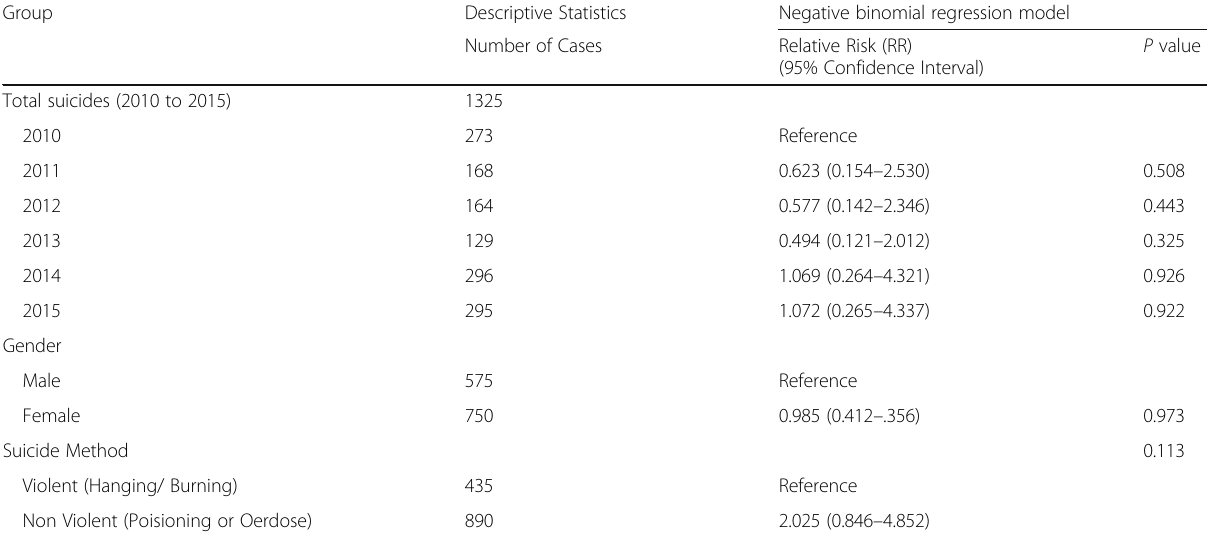
Table 5 Negative Binomial regression model for Relative Risk (RR) (95% Confidence Interval) Group Descriptive